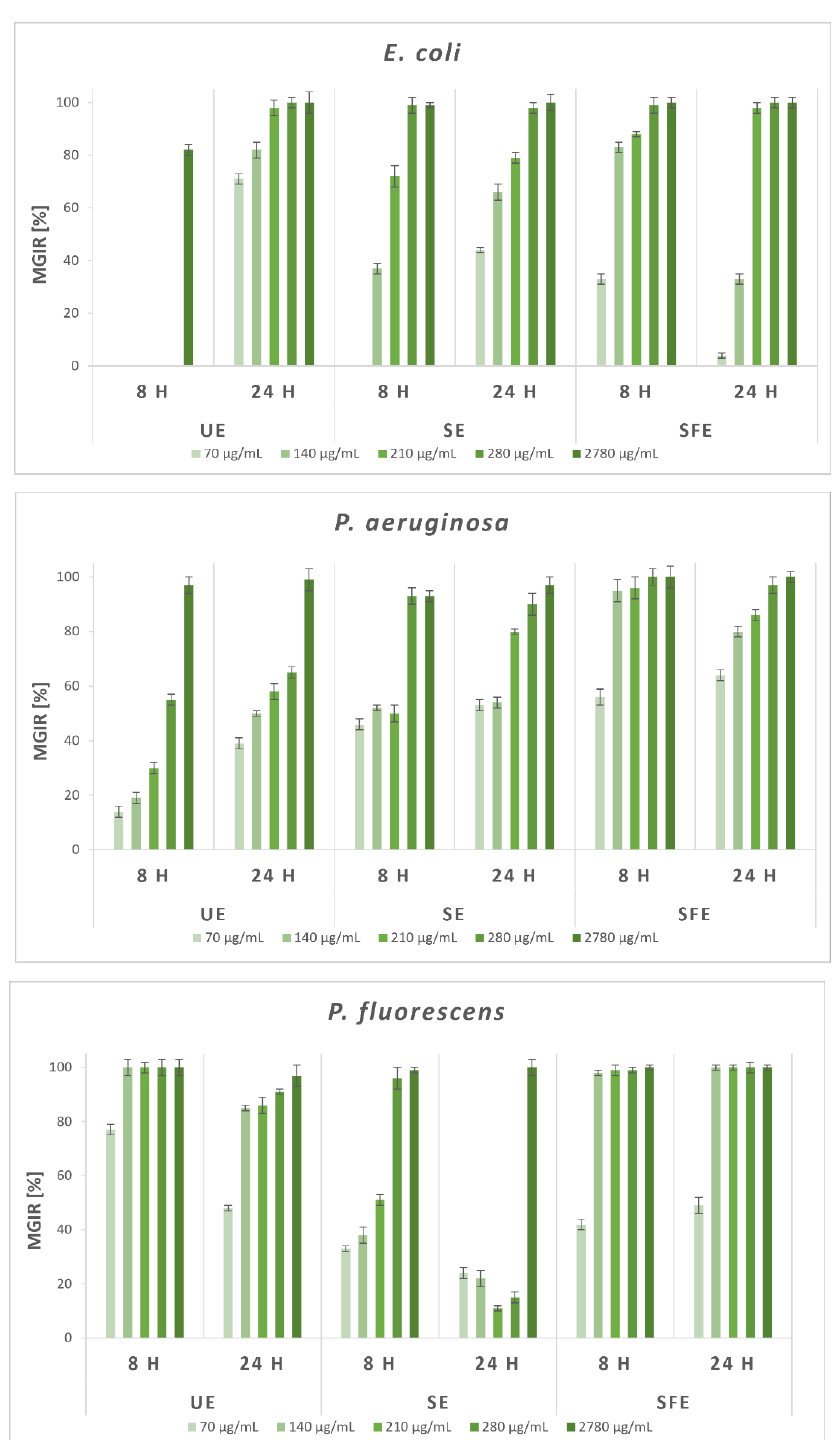
Figure 4. Microbial growth-inhibition rates (MGIRs) for AS extracts obtained by ultrasonic extrac- tion (UE; solvent H 2 O), Soxhlet extraction (SE; solvent EtOH), and supercritical fluid extraction (SFE; solvent scCO 2 , co-solvent EtOH) using 70, 140, 210, 280, and 2780 μ g sample per mL of selected Gram-negative bacteria suspension.